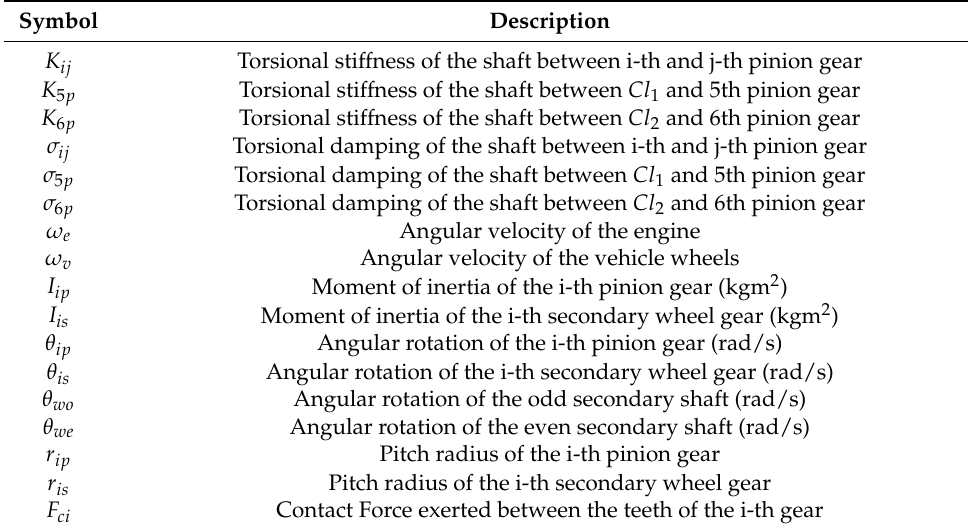
Table 1. Symbols in the motion